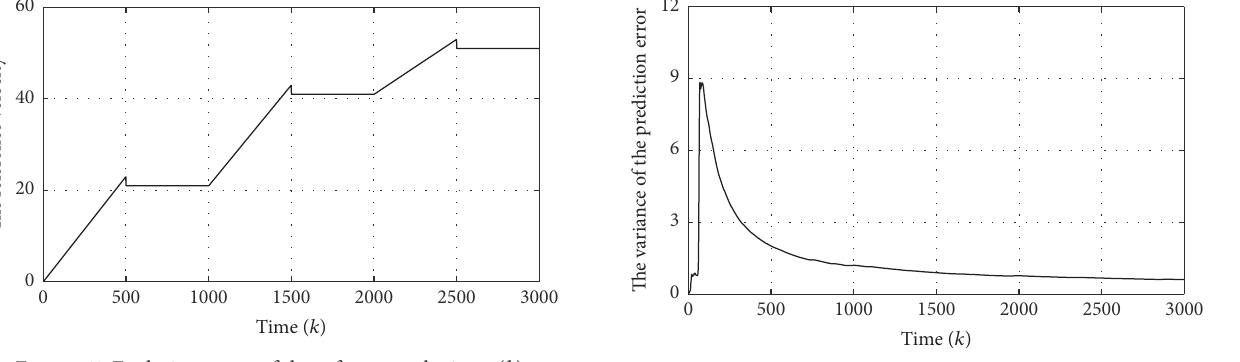
Figure 11: Evolution curve of the reference velocity 𝑦 𝑟 (𝑘) .